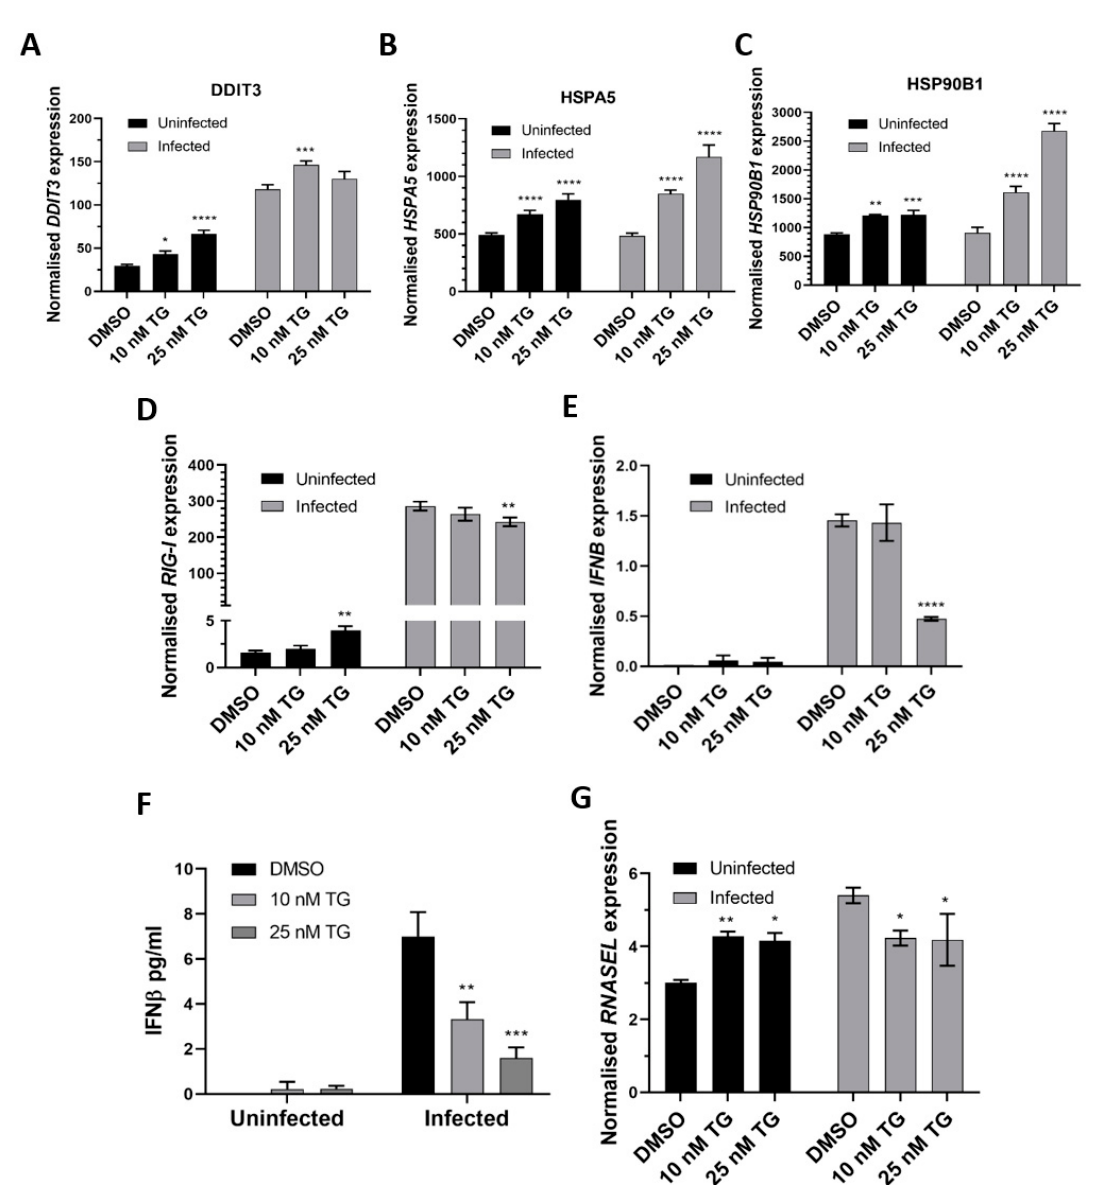
Figure 3. TG priming of NHBE cells increases expression of the ER stress genes (pre- and post-infection) and basal expression of the RIG-I signalling-associated genes, but during infection, induction of the RIG-I-associated genes is attenuated. Cells were primed with TG or DMSO control for 30 min, washed with PBS and infected with RSV at 0.05 MOI 48 h after which total RNA was extracted for cDNA conversion to quantify expression of the ER stress genes ( A ) DDIT3 , ( B ) HSPA5 and ( C ) HSP90B1 . Expression was normalised to 18s rRNA and the indicated significance, determined by 2-way ANOVA (Sidak’s multiple comparisons), is relative to the corresponding DMSO control. There was consistent indication of pre-infection activation of the RIG-I-associated genes, RIG-I ( D ), IFNB ( E ) (and corresponding IFNB protein, ( F )) and RNASEL ( G ) from TG priming. IFNB ELISA was performed on supernatants at 16 hpi. All RNA expression was normalised to 18s rRNA and the indicated significance, determined by one-way ANOVA and Dunnett’s multiple comparisons ( D ), or 2-way ANOVA Tukey’s multiple comparisons ( E – G ), is relative to the corresponding DMSO control. All assays were in triplicates and were performed three times. * p < 0.05, ** p < 0.01, *** p < 0.001 and **** p < 0.0001.